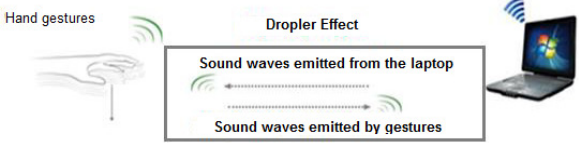
Figure. 4. Human-Computer interaction thourgh hand gestures using the Dropler